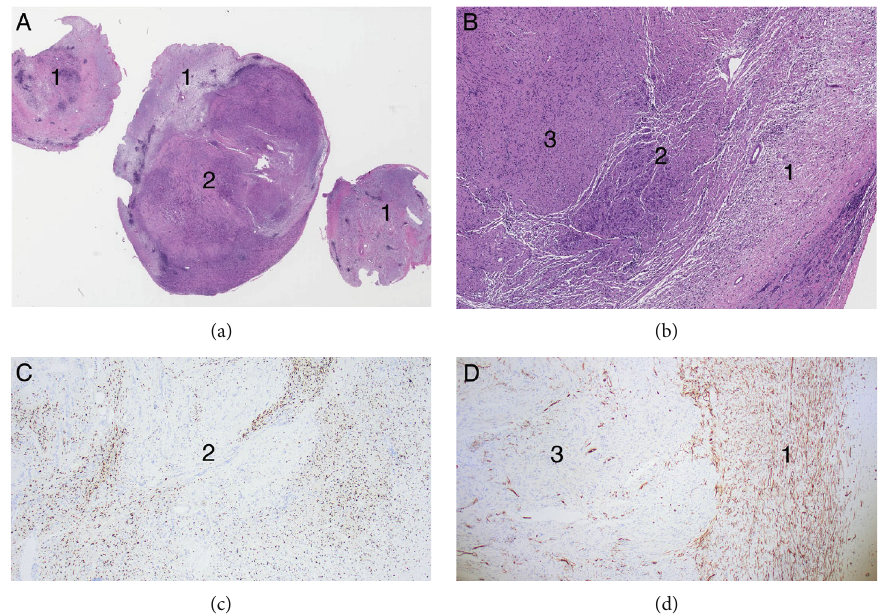
Figure 2: Histopathology of hybrid neuro fi broma/schwannoma component. Low-magni fi cation images ((a) 40x and (b) 100x) identify the neuro fi broma (A1/B1), schwannoma (B3), and metastatic carcinoma (A2/B2). Immunohistochemistry for SOX10 (c) is positive within the NF and schwannoma portions, but negative in the carcinoma portions (C2). CD34 (d) is negative within the schwannoma component (D3) and exhibits the so called “ thumbprint ” appearance in the NF component